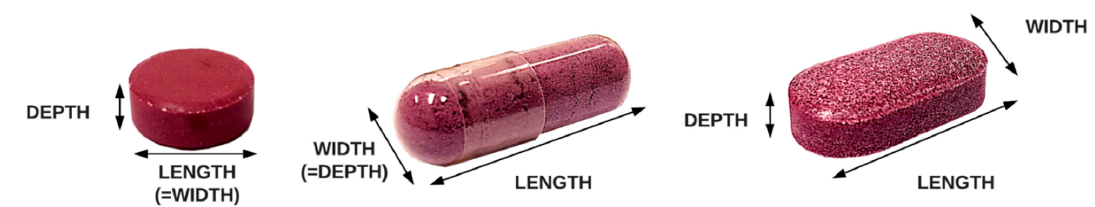
Figure 1. Indices of supplements formulations size.